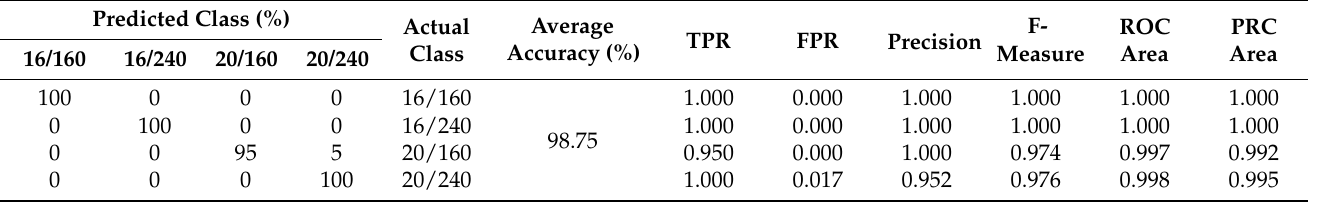
Table 2. The discrimination metrics of leaves of cv. ‘Casual’ romaine lettuce grown under different light environments (photoperiod 16 and 20 h and PPFD 160 and 240 µ mol m − 2 s − 1 ) for the model built based on textures from all color channels of images using the Multilayer Perceptron machine learning algorithm.